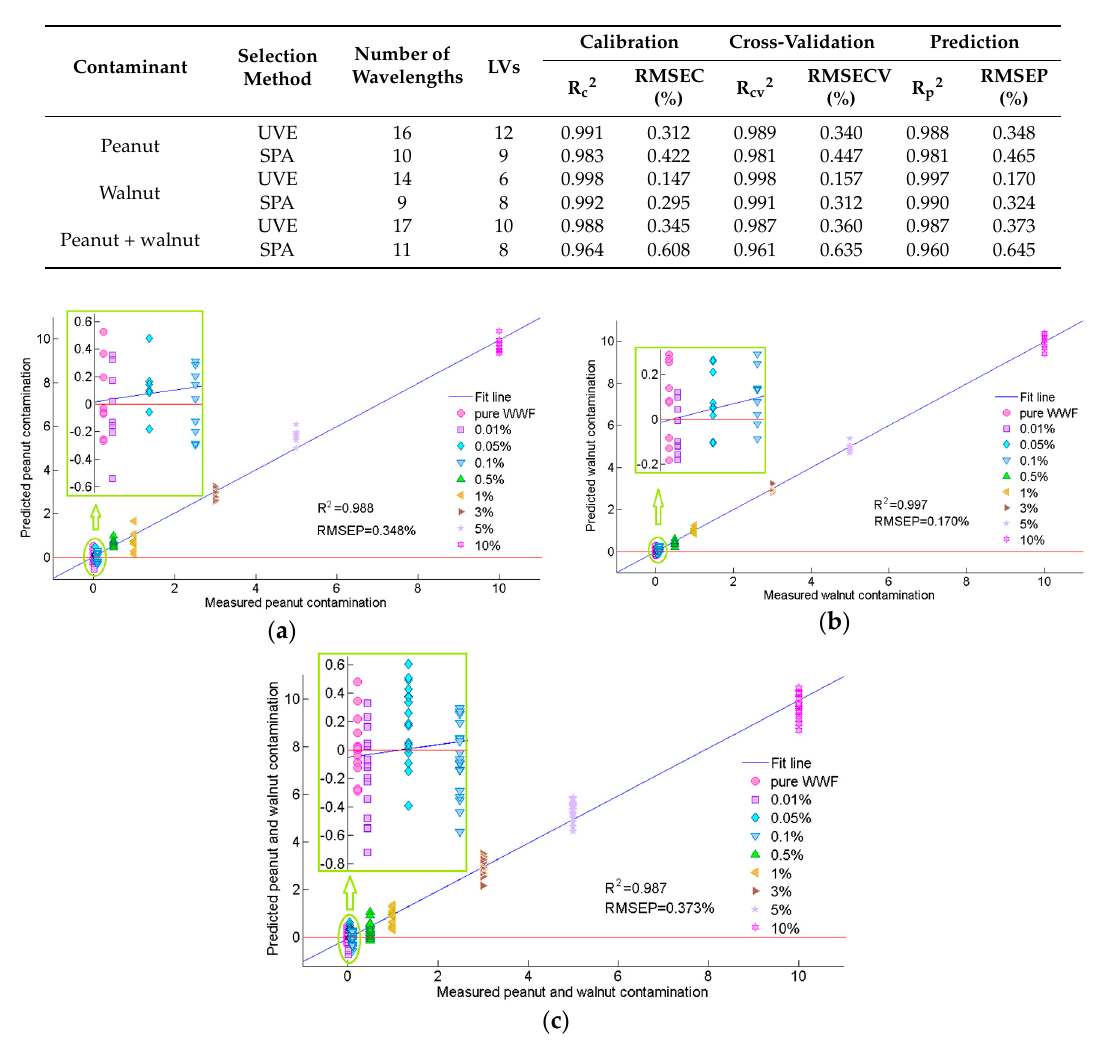
Figure 3. Performance of the best multispectral PLSR models for ( a ) peanut-contaminated flour; ( b ) walnut-contaminated flour; and ( c ) combination of both peanut-contaminated flour and walnut-contaminated flour applied on prediction sets based on the corresponding selected feature wavelengths (an enlarged view of the green circle part was shown in the green pane).